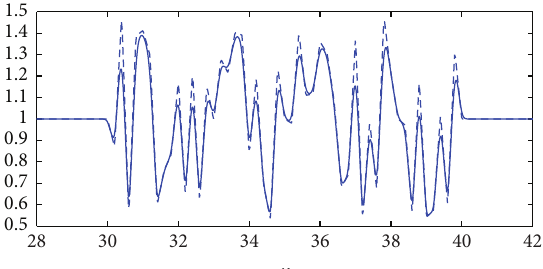
Figure 14: The metric coefficient 𝑀(𝜉, 𝛽 = 0.01) (in solid line) comparedwitha(nondifferentiable)piecewiselineartopography(in dashed line). Observe that the coefficient 𝑀 is smooth even though the physical topography is not differentiable. The irregular part of the bottom is located over the interval [30, 40] and the channel’s bottom is flat outside this